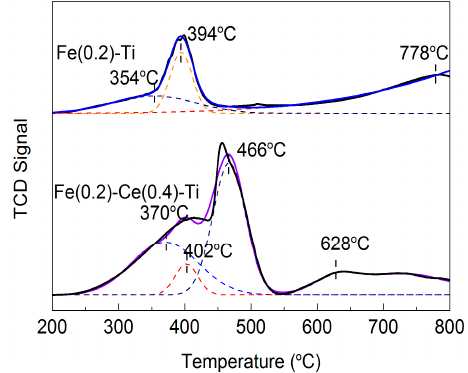
Figure 6. H 2 ‐ TPR profiles for Fe(0.2)–Ti and Fe(0.2)–Ce(0.4)–Ti catalysts. Figure 6. H 2 -TPR profiles for Fe(0.2)–Ti and Fe(0.2)–Ce(0.4)–Ti Table 2. XPS results of various catalysts.